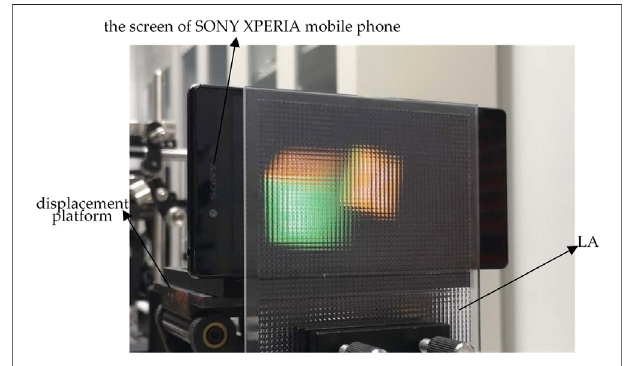
FIGURE 9 | Experimental setup of the display system.